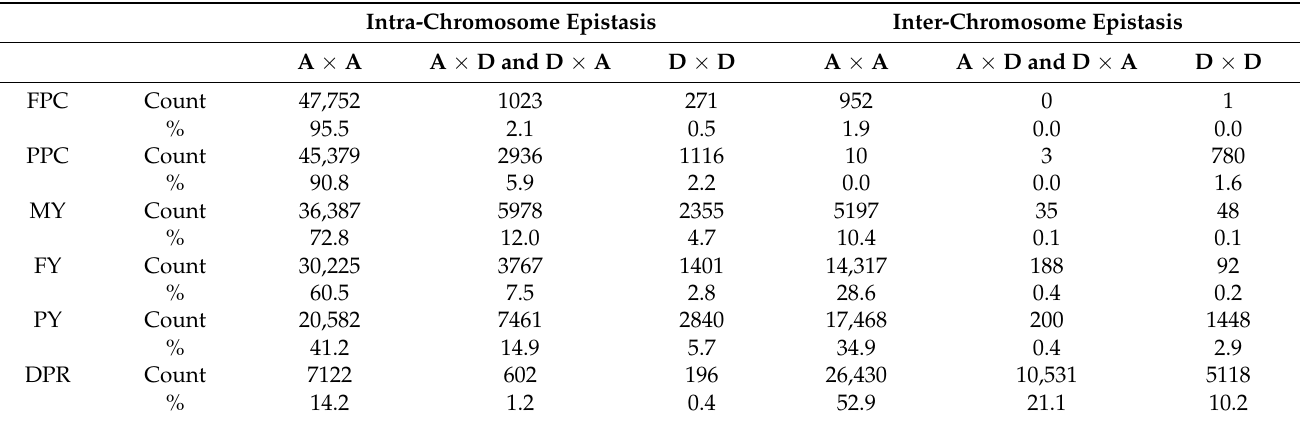
Table 2. Frequencies of A × A, A × D/D × A and D × D epistasis effects within intra- and inter-chromosome pairwise epistasis effects among the top 50,000 epistasis effects.